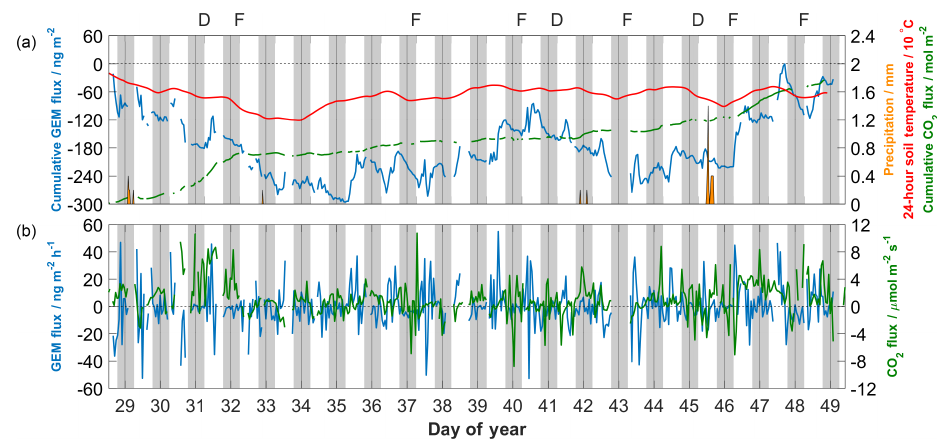
Figure 3. (a) Cumulative GEM and CO 2 fluxes across the study period, along with precipitation and 24h running means of soil temperature at 2cm depth. Colours match those of axis labels. Observations of dew and fog are denoted above by “D” and “F”, respectively. (b) 60min GEM and CO 2 fluxes over the study period.